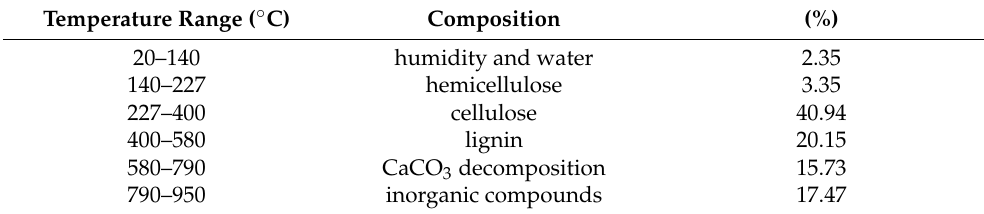
Table 1. Agave fiber composition obtained from the thermogravimetric analysis. Temperature Range ( ◦ C) Composition